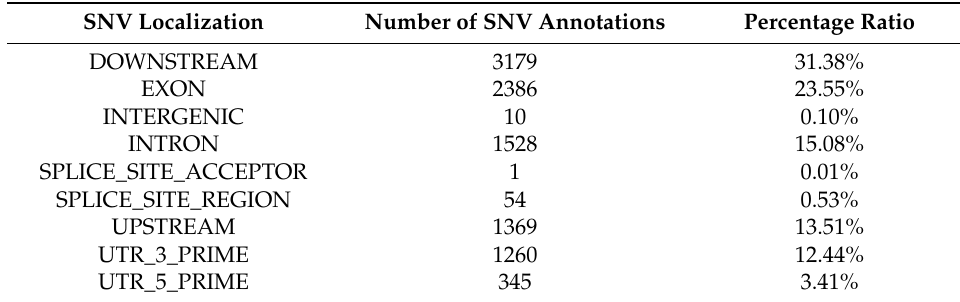
Table 5. Distribution (%) of significant SNV ( ∆ AFF; FDR < 0.05) annotated according to gene components (upstream region, 5’UTR, CDS, intron, 3’UTR, and downstream region). SNV Localization Number of SNV Annotations Percentage Ratio DOWNSTREAM 3179 31.38% EXON 2386 23.55% INTERGENIC 10 0.10% INTRON 1528 15.08% SPLICE_SITE_ACCEPTOR 1 0.01% SPLICE_SITE_REGION 54 0.53% UPSTREAM 1369 13.51% UTR_3_PRIME 1260 12.44% UTR_5_PRIME 345 3.41%